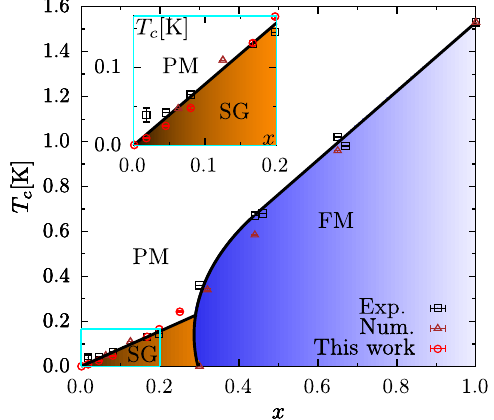
FIG. 2. Transition temperature T c versus concentration x phase diagram obtained from our simulations (circles), previous sim- ulations from Refs. [19,32] (triangles), and experimental data from Refs. [6,18,25,43,44] (squares). The straight line between the spin-glass (SG) and paramagnetic (PM) phases is a linear fit to the data for small concentrations. Our results suggest that the spin-glass phase extends to the x ¼ 0 þ limit, as can be seen in more detail in the inset. For large concentrations and low temperatures, the system is a ferromagnet (FM).